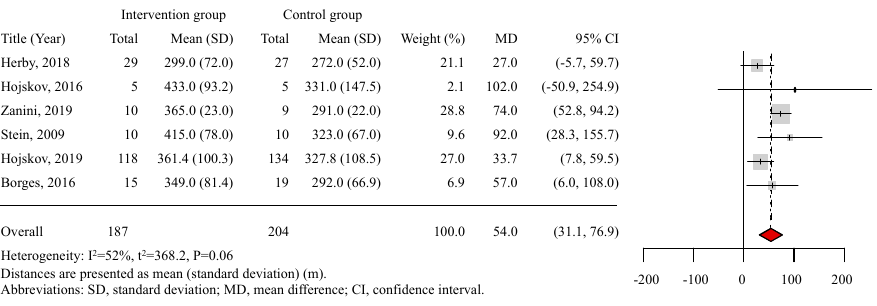
Figure 4. Meta-analysis. Distances are presented as mean (standard deviation) (m). Legends: SD, standard deviation; MD, mean difference; and CI, confidence interval.